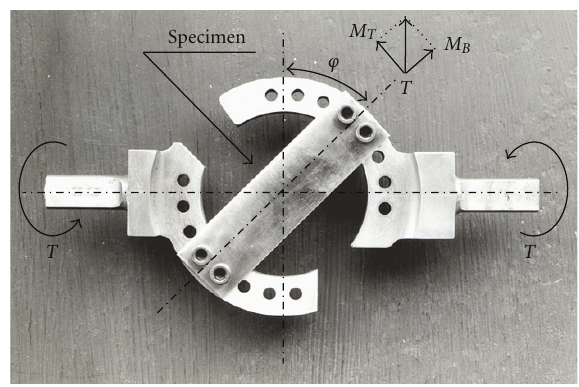
Figure 6: Bending-torsion apparatus.